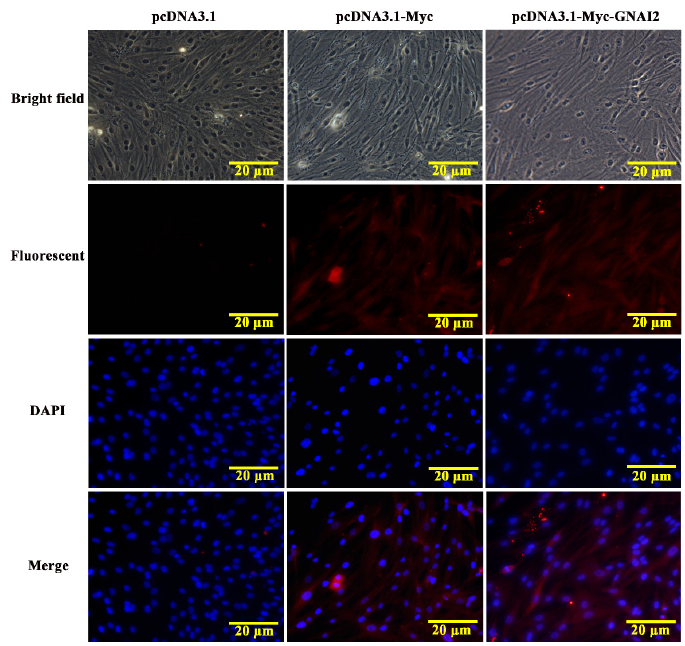
Figure 2. The localization of GNAI2 protein in melanocytes (400X). The subcellular localization of GNAI2 in melanocytes was determined using an indirect immunofluorescence staining assay. The pcDNA3.1 group was used as a negative control and the pcDNA3.1-Myc group was used as a positive control.